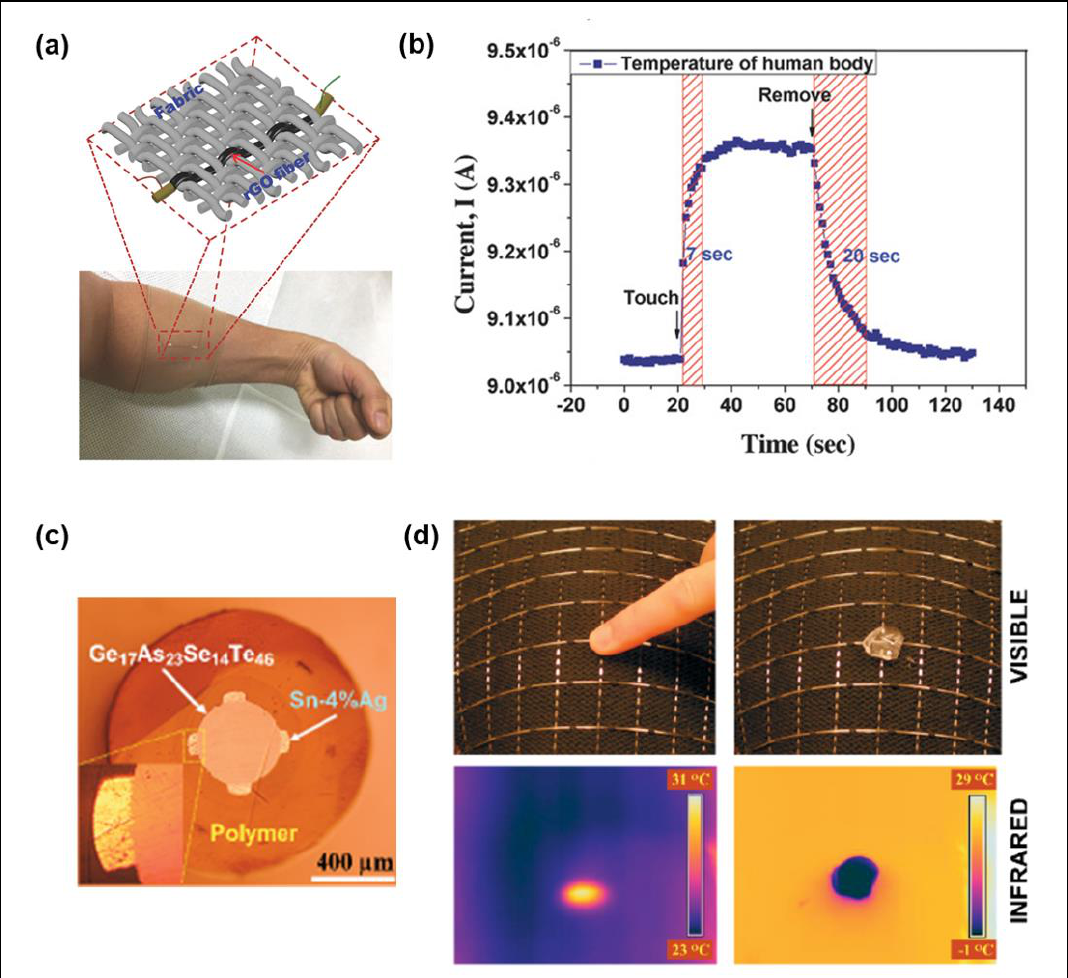
Figure 5. Temperature sensing fiber. ( a ) Schematic of an RGO-based fiber knitted into the fabric and worn on the arm. ( b ) The fiber showed fast response time (7 s) and a great recovery time of (20 s). Reproduced with permission from [38], Copyright (2018), Wiley. ( c ) Cross-sectional micrograph image of the chalcogenide-based fiber. ( d ) The 8 × 8 fiber array detected heating locally with the touch of a finger and cooling with a piece of ice. Reproduced with permission from [25], Copyright (2006), Wiley.